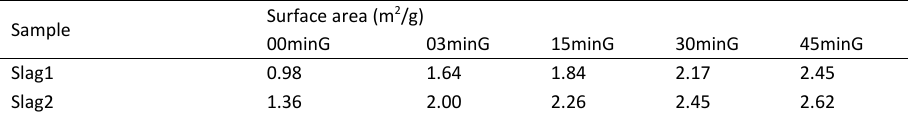
Table 3. The BET surface areas of the samples used in this